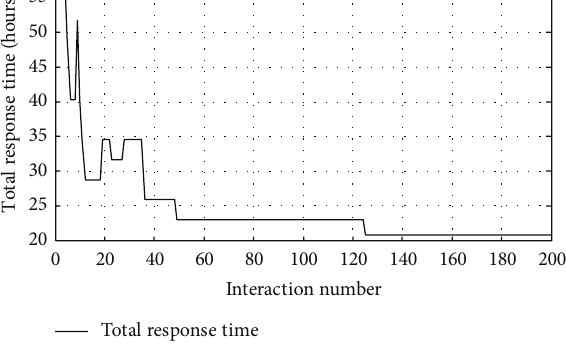
Figure 5: Optimization of the fitness